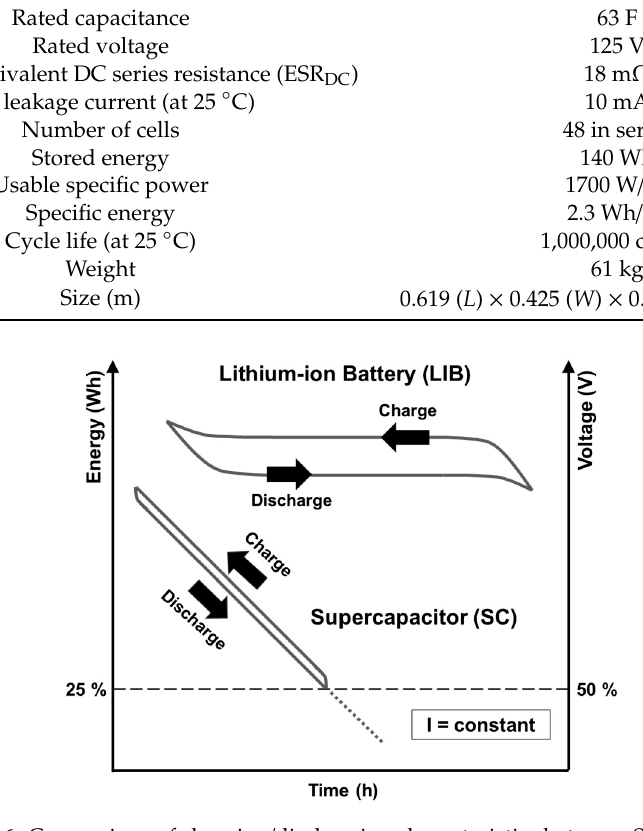
Figure 6. Comparison of charging/discharging characteristics between SC and LIB. Table 10. Specifications of the selected SC pack.